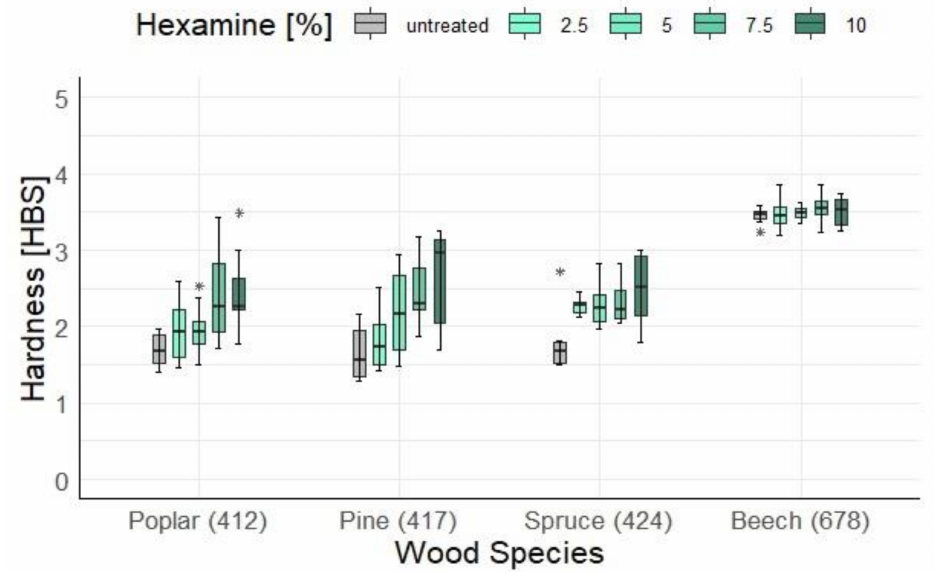
Figure 7. Boxplot chart of Brinell surface hardness for different wood species at various hexamine amounts. The symbol “ * ” indicates the outliers of the tests